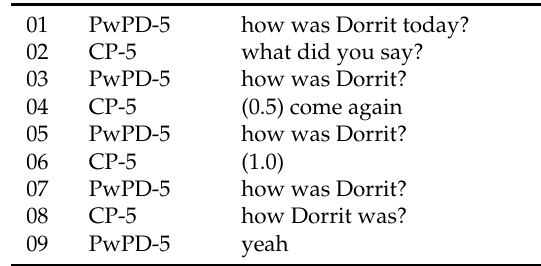
Figure 2. Impaired speech, multiple attempts to